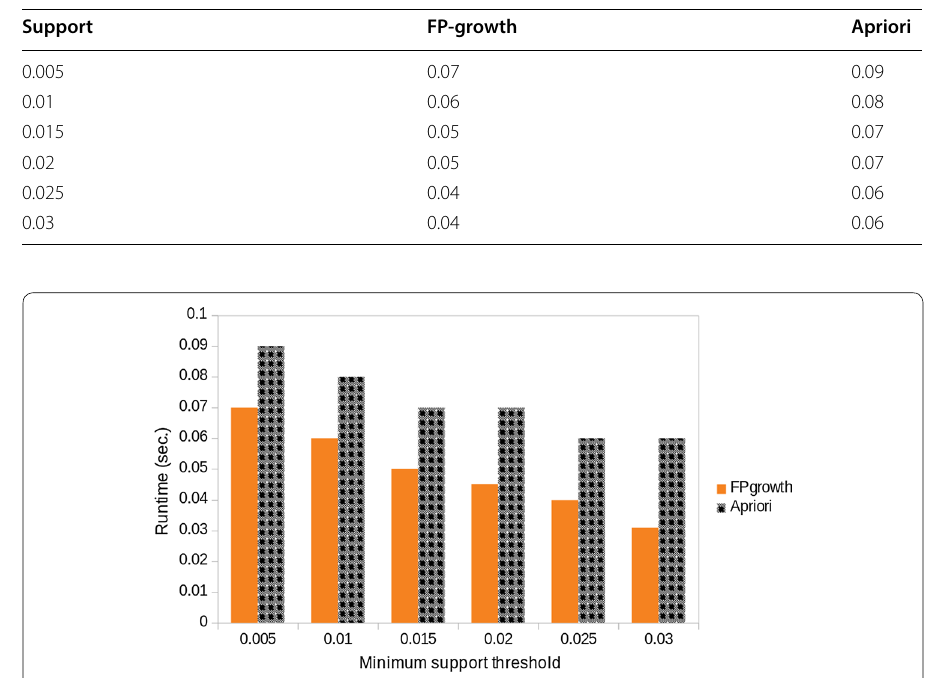
Fig. 8 Performance of FP-growth vs Apriori based on the support threshold: the experiments results shows that parallel FP-growth algorithm is more faster than